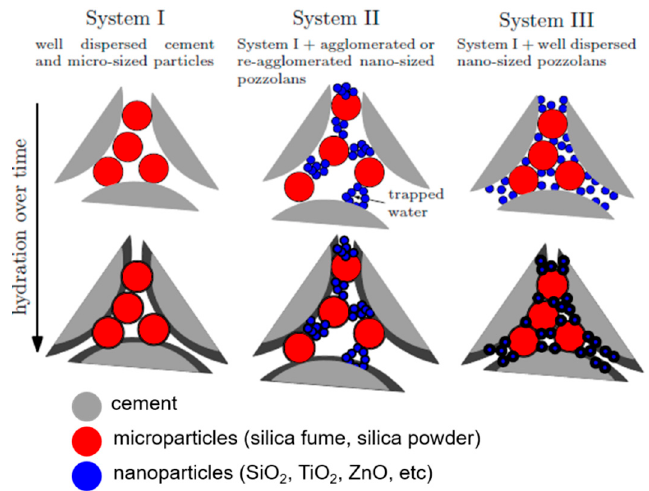
Figure 1. Illustrating the effects of poorly dispersed and well dispersed nanosilica (NS) in a cement system.